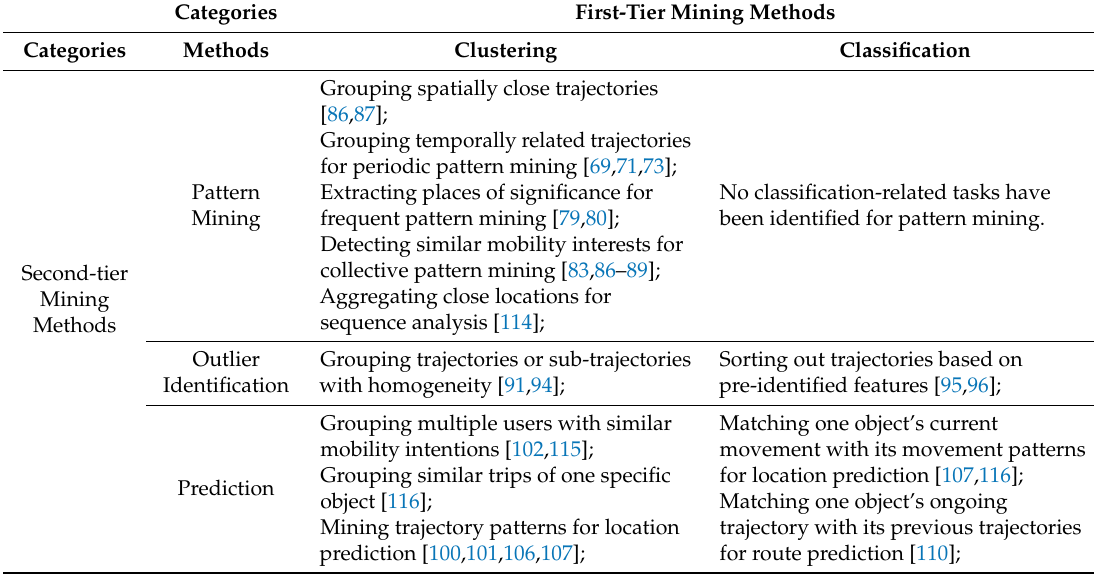
Table 1. Relationships between trajectory data mining